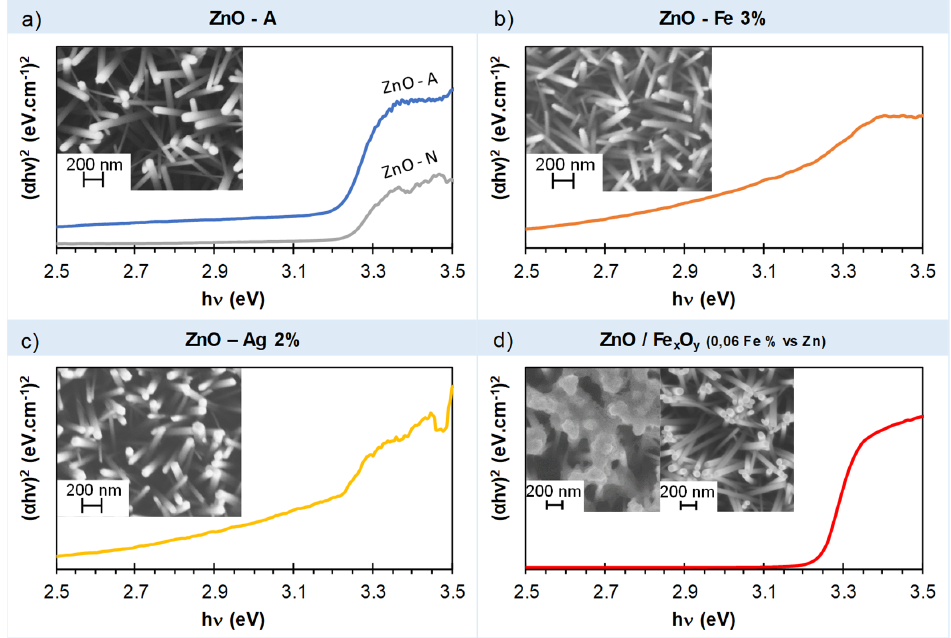
Figure 5. UV–visible spectral plots with Tauc-Lorentz model and SEM images of different modified ZnO NWs: ZnO-A ( a ), ZnO – Fe 3% ( b ), ZnO – Ag 2% ( c ), and ZnO/Fe x O y (0.06 Fe % vs Zn), respectively. ( d )